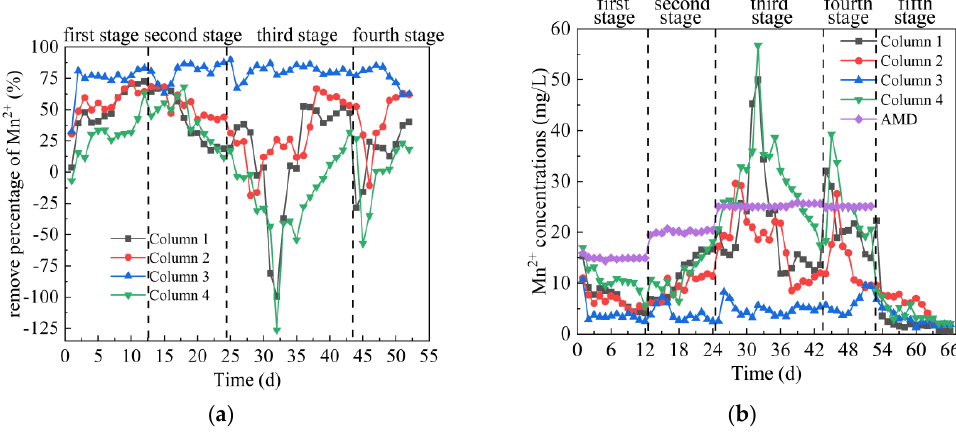
Figure 7. Changes of Mn 2+ removal effect of SRB combined with Coal Gangue 1–4 to repair AMD. ( a ) Mn 2+ removal percentage; ( b ) Mn 2+ concentration. ( a ) Mn 2 + removal percentage; ( b ) Mn 2 +